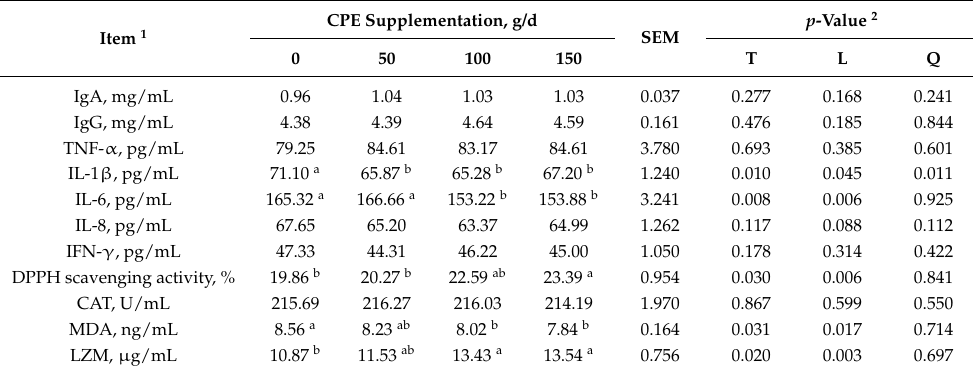
Table 1. Effects of feeding citrus peel extract (CPE) on biochemical parameters of milk from dairy cows. Item